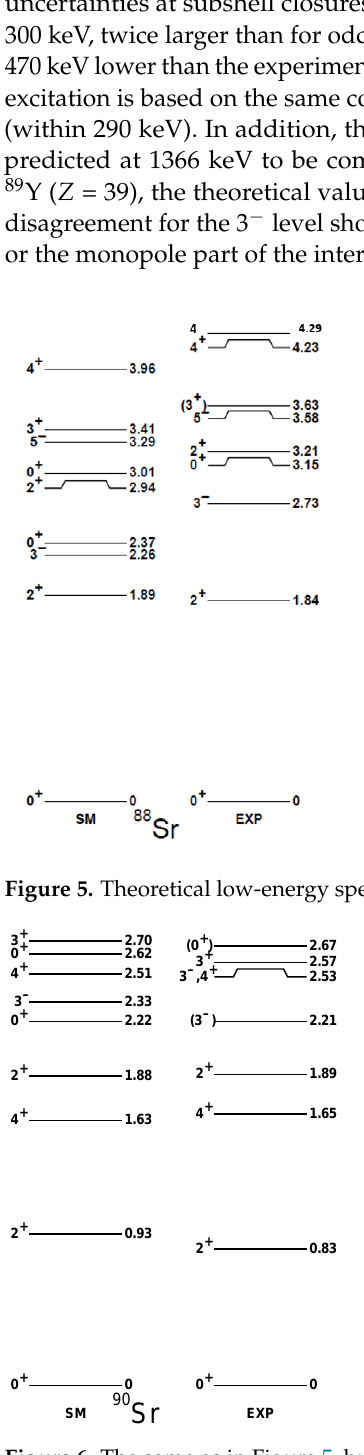
Figure 6. The same as in Figure 5, but for 92